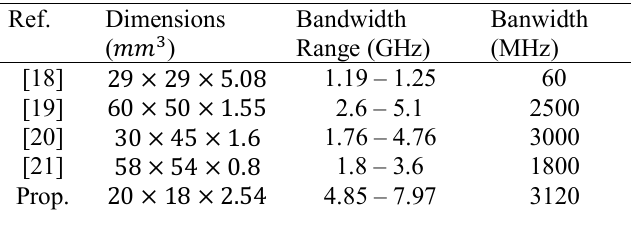
Table 1. Comparision of the proposed design with those present in the